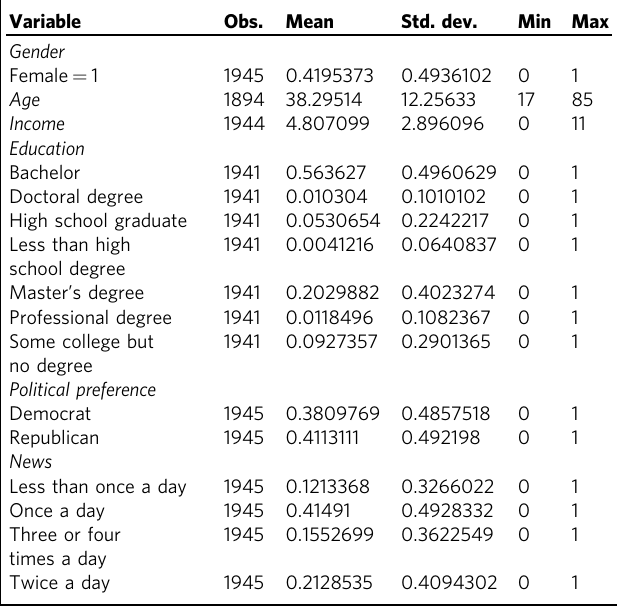
Table 1 Descriptive statistics.